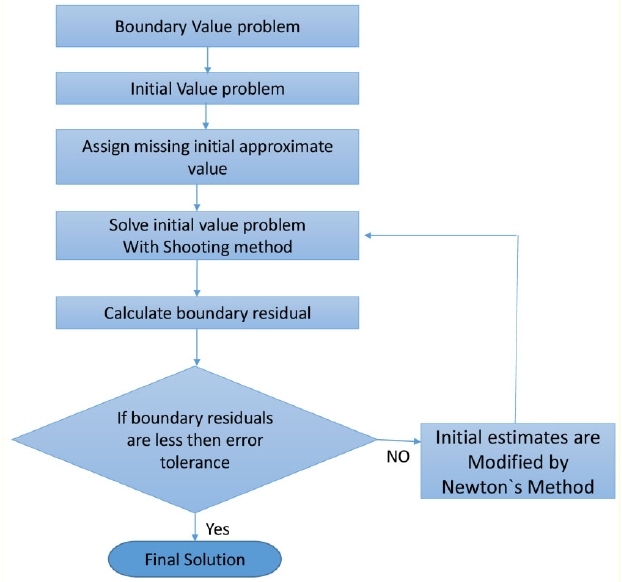
Figure 3. Flow chart of the numerical algorithm. Table 1. Variation of radial velocity in the suction case for the viscous fluid; 𝑀 (cid:3404) 0, 𝑅 (cid:3404) (cid:3398) 50 . 𝜶 𝜼